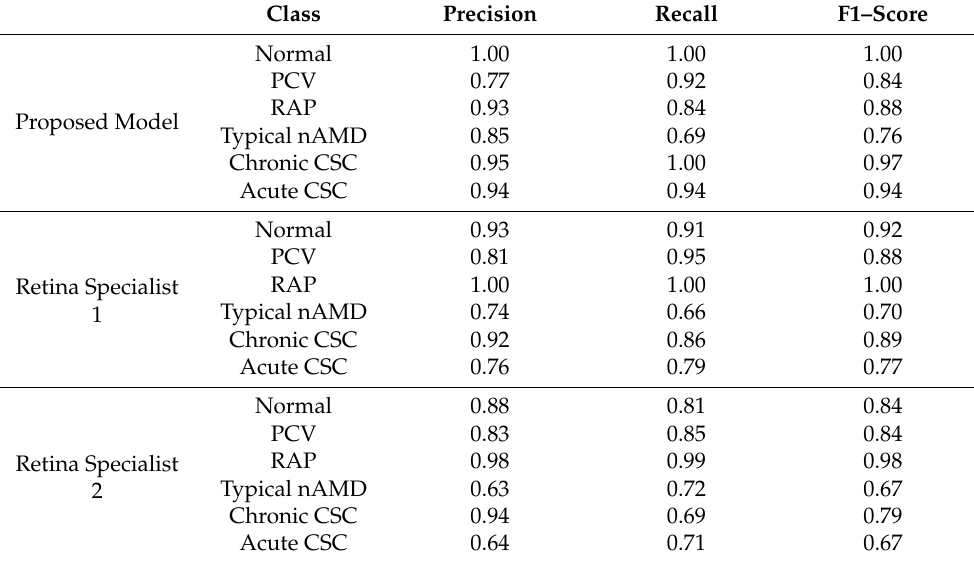
Table 3. Comparative results of classification performance of the proposed model and two retina specialists. Class Precision Recall F1–Score